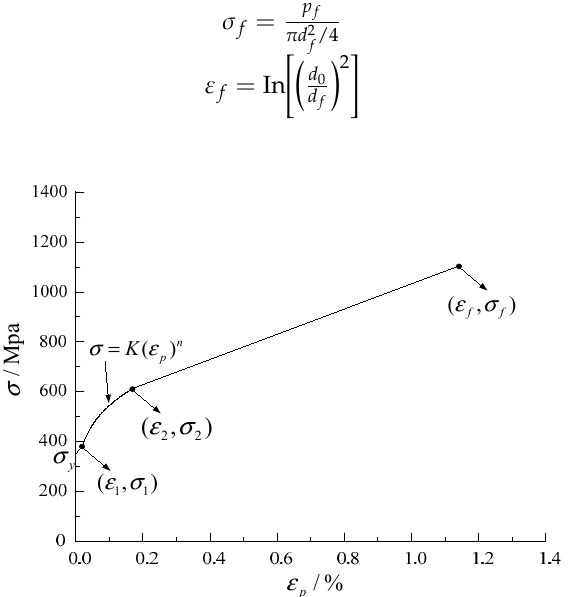
Table 1. Mechanical properties of Q345qC steel.